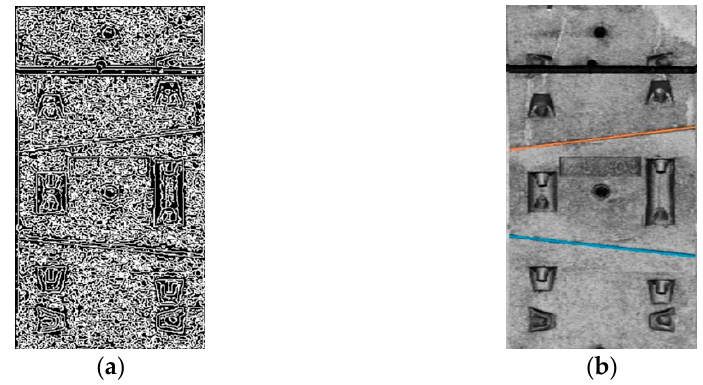
Figure 8. ( a ) Canny edge detection result. ( b ) Hough line detection result.